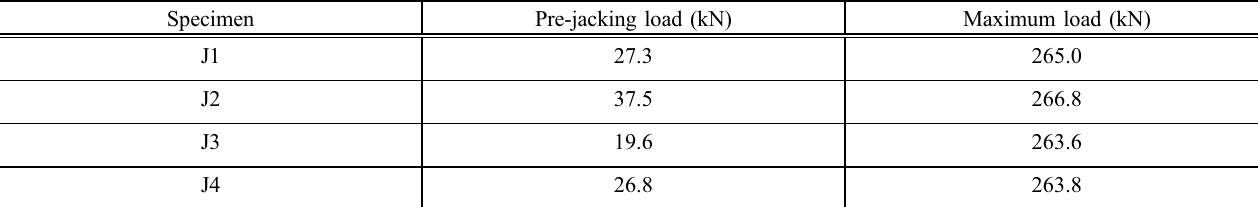
Table 2 Pre-jacking loads and maximum loads in jacking tests.